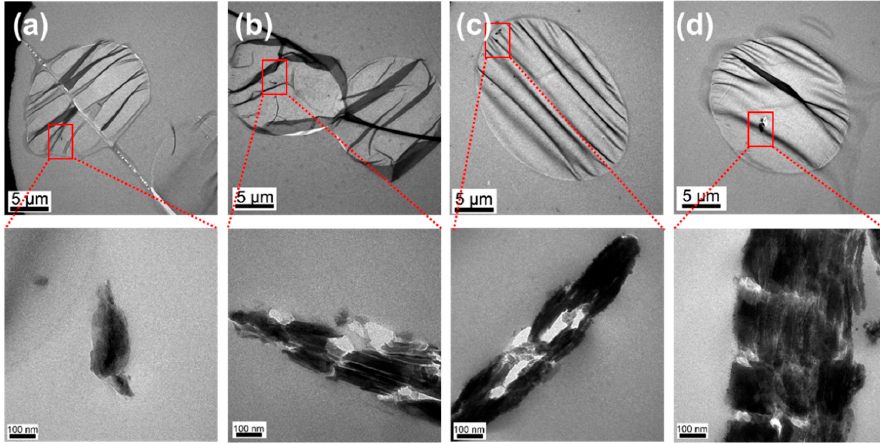
Figure 3. TEM images of ( a ) PET/Cu 2 O@ZrP-I-0.2%, ( b ) PET/Cu 2 O@ZrP-I-0.6%, ( c ) PET/Cu 2 O@ZrP-B-0.2% and ( d ) PET/Cu 2 O@ZrP-B-0.6%,